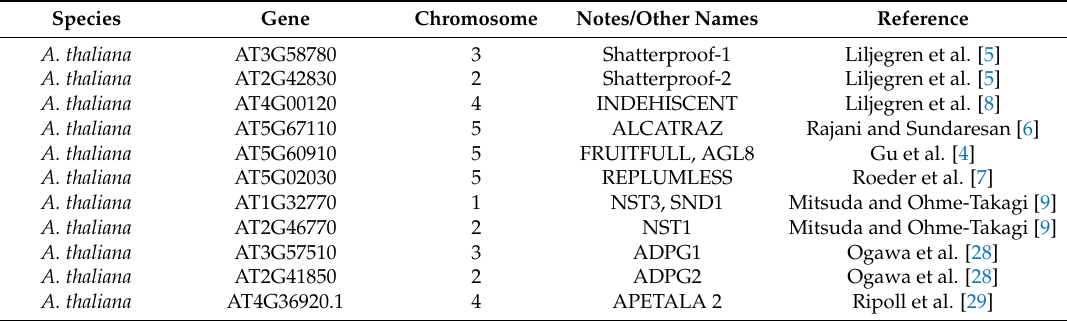
Table 2. Genes involved in seed shattering in the model species A. thaliana and in relevant crops.